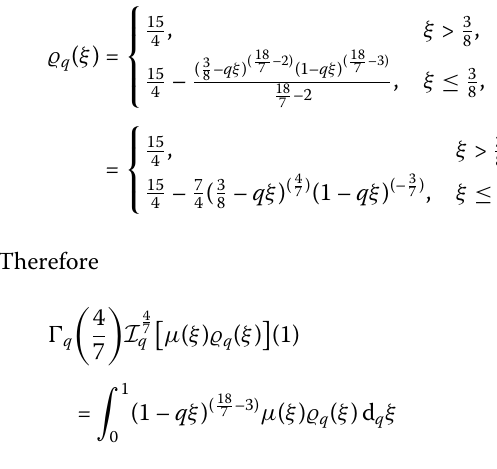
and μ ( t ) = 1– t 2 , then assumption (A1) holds. Now we verify assumption (A2). 1+ t 2